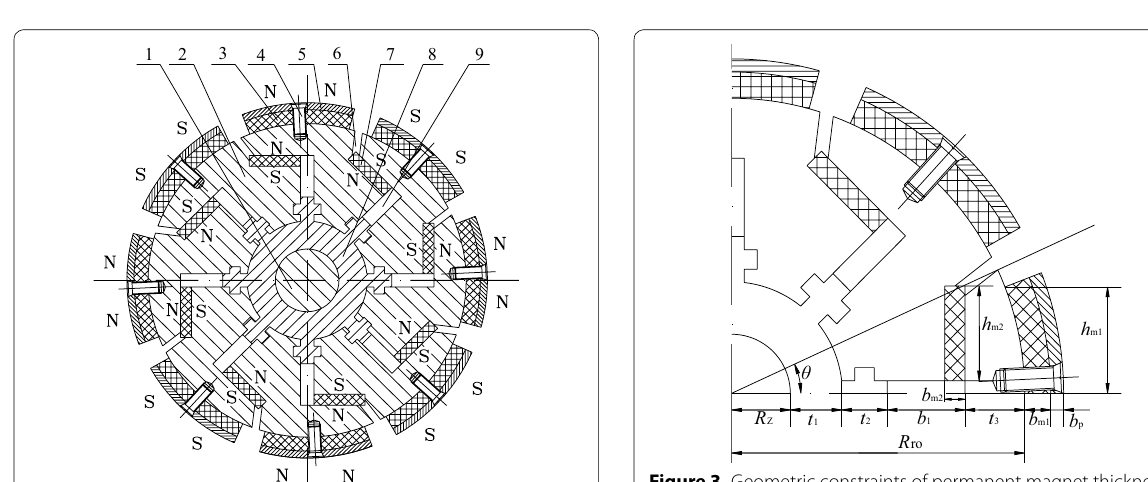
Figure 3 Geometric constraints of permanent magnet